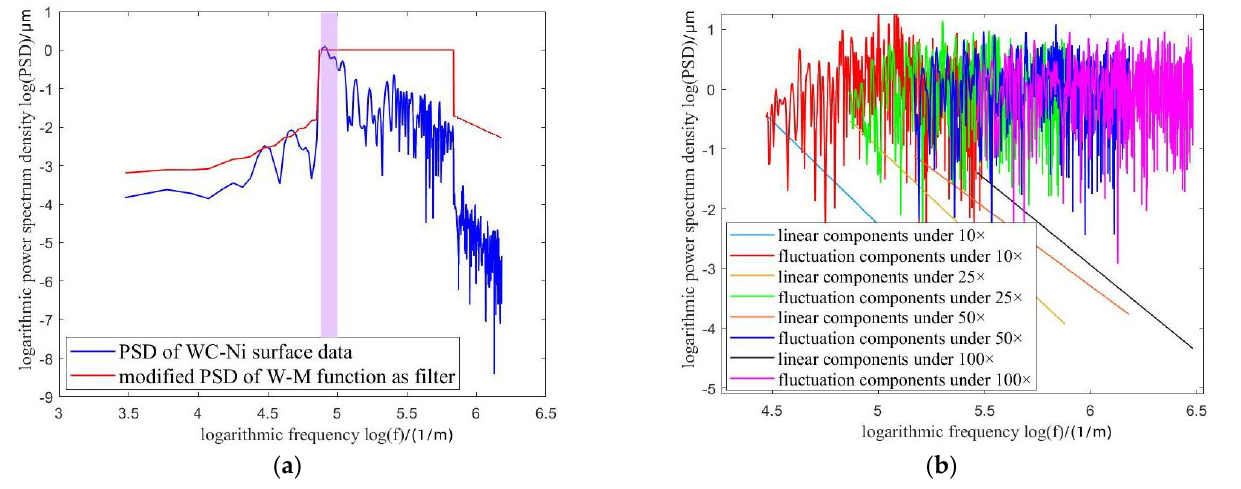
Figure 5. Operation processes on the measured data. ( a ) determination of scale-free region; ( b ) com- ponent decomposition and filtering fluctuation components.